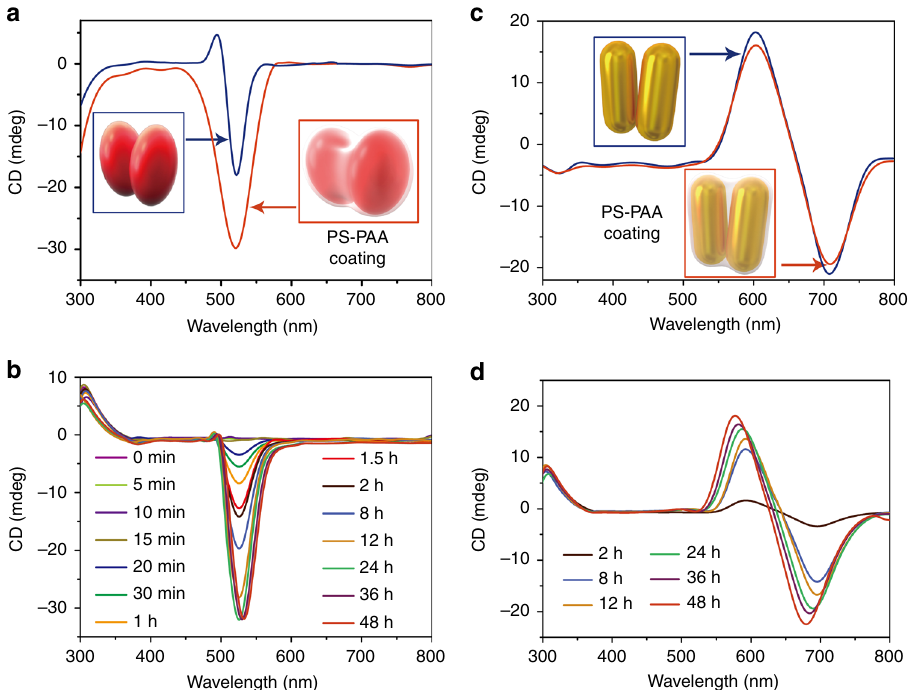
Fig. 3 Transmembrane transport and chiroptical activity of NP ( a , b ) and NR ( c , d ) dimers with PS-PAA shells with stationary conformation. a CD spectra for NP dimers in buffer before and after encapsulation by PS-PAA and ( b ) their temporal progression upon incubation with HeLa cervical cancer cells indicating the gradual cellular incorporation but no change in the sign of the chiroptical activity. The spectroscopic measurements at each time point were performed after the removal of extracellular excess of NP dimers. Statistical analysis of the dihedral angles for NP dimers before and after encapsulation by PS-PAA is given in Supplementary Fig. 23. c CD spectra of NR in buffer before and after encapsulation by PS-PAA, and ( d ) their temporal progression upon incubation with HeLa cells; the spectroscopic measurements at each time point were performed after the removal of extracellular excess of NP